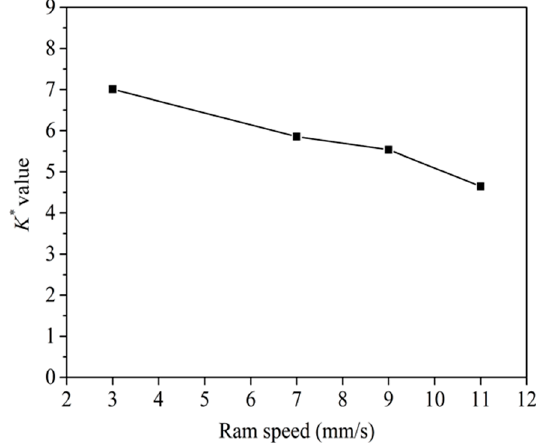
Figure 6. The relationship between the ram speed and K * value.